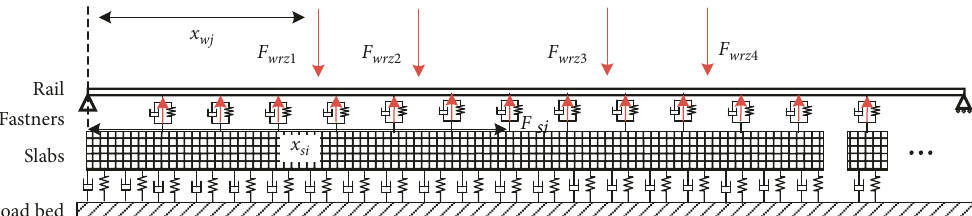
Figure 7: Monolithic concrete bed track model.